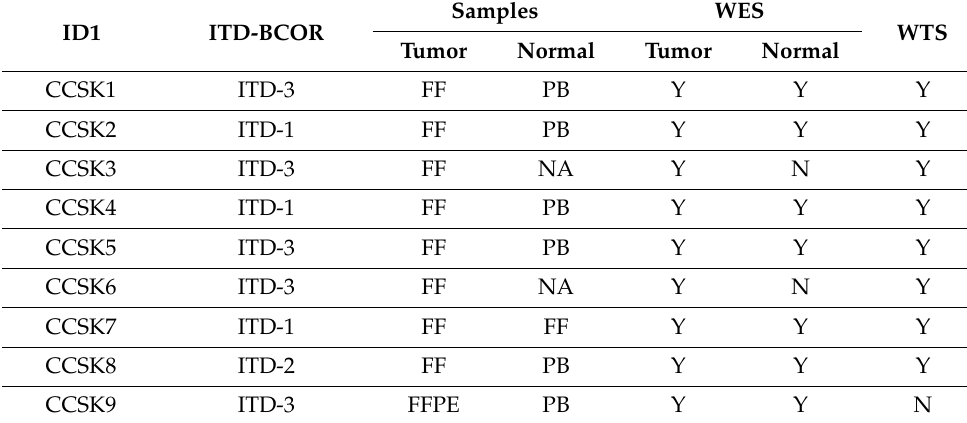
For all CCSKs, the primary tumor sample was analyzed, and the presence of BCOR- ITD was confirmed by PCR and Sanger sequencing. Three different BCOR-ITDs were identi- fied (Figure S1): ITD-1 (c.5136_5225dup) was found in CCSK 2-4-7, ITD-2 (c.5099_5212dup) in CCSK 8, and ITD-3 (c.5171_5266dup) in CCSK 1-3-5-7-9 (Table 2). Table 2. Samples’ features. FF, fresh frozen specimen; FFPE, formalin-fixed paraffin-embedded; PB, peripheral blood; WES, whole-exome sequencing; WTS, whole-transcriptome sequencing. ITD-1: c.5136_5225dup; ITD-2: c.5099_5212dup; ITD-3: c.5171_5266dup. Samples ID1 ITD-BCOR Normal